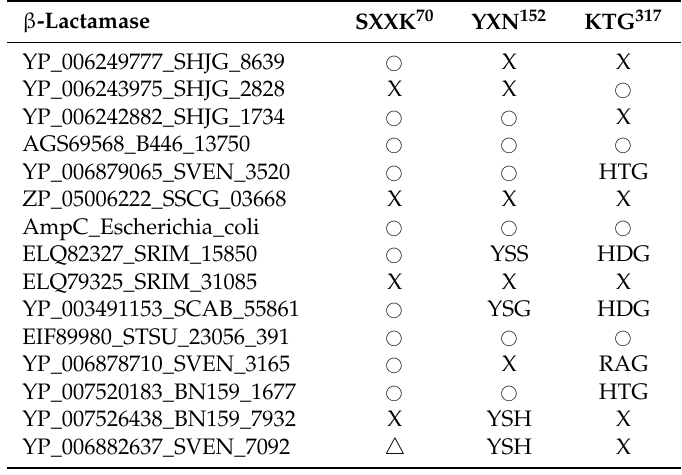
Table 5. Presence or absence of active site residues in class C β